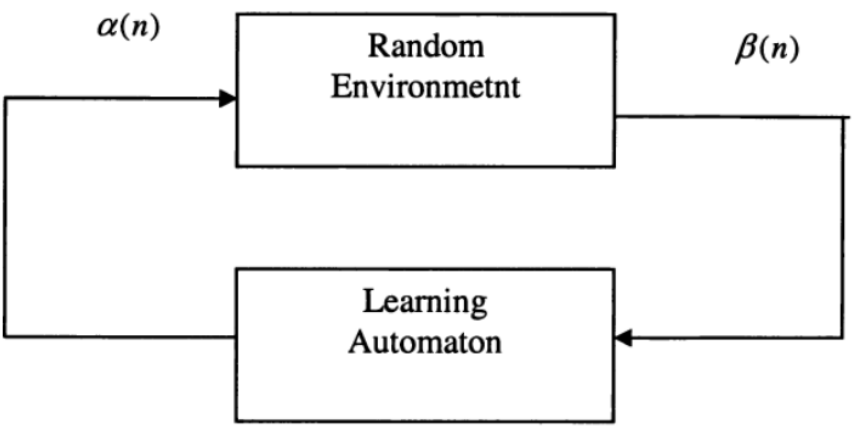
Figure 3. The relationship between the learning automaton and its random environment.